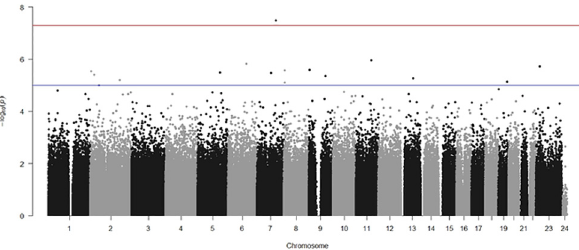
Fig 1. Manhattan plot of the SNPs tested in the pooled DNA association